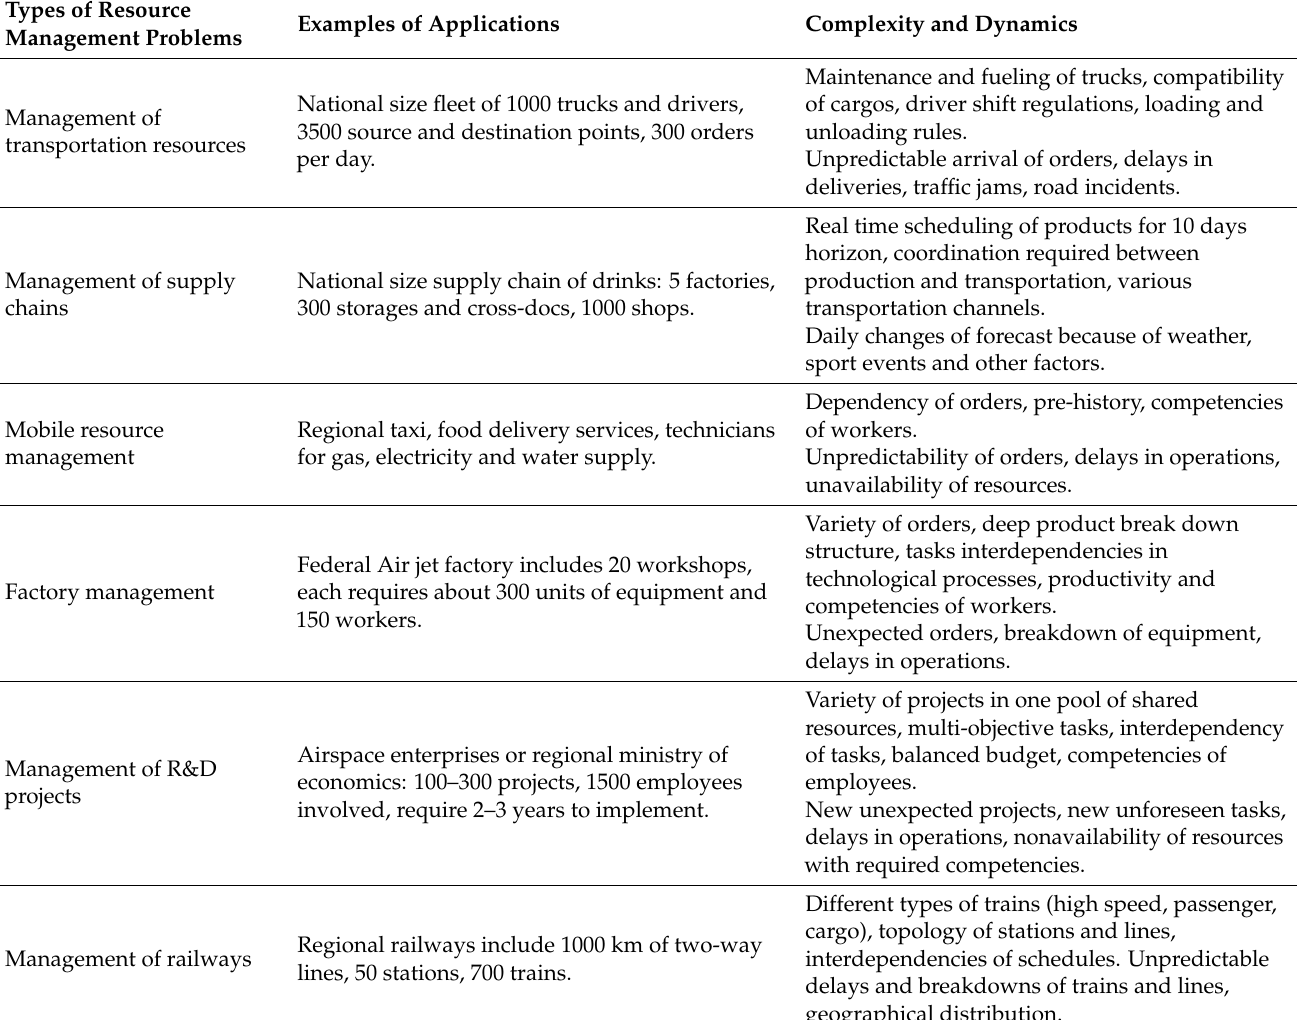
Table 1. Examples of complex and dynamic resource management